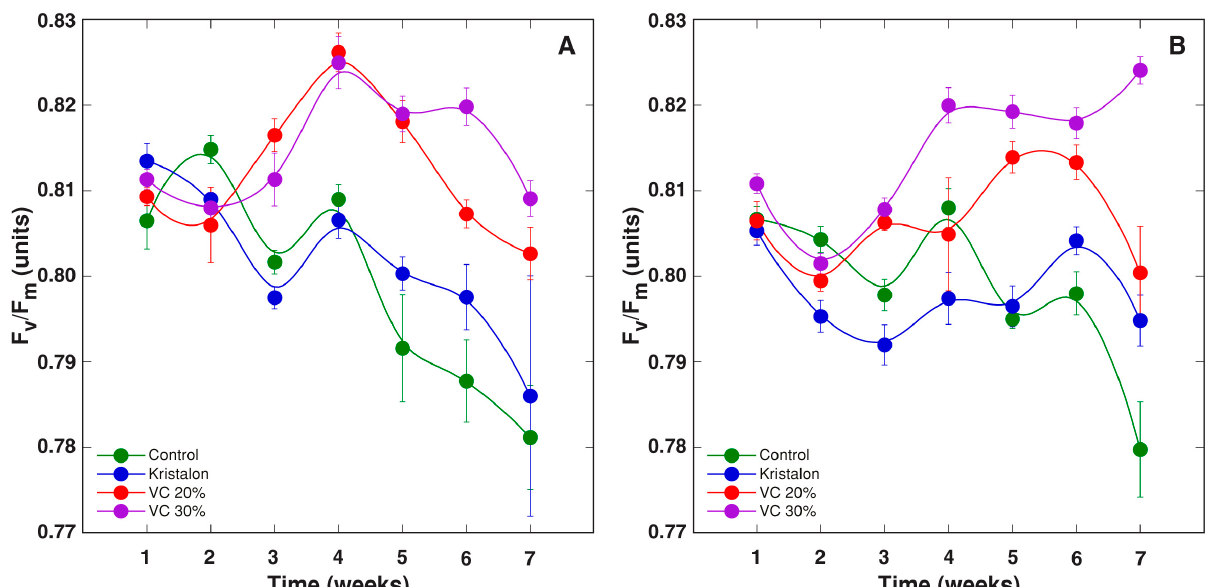
Figure 9. Changes of chlorophyll a fluorescence parameter F v /F m as affected by mineral fertilizer (Kristalon) and amendment with vermicompost (VC) at a 20% and 30% ( v/v ) rate in Dracocephalum moldavica plants grown in peat substrate ( A ) or commercial garden soil ( B ). Results are means ± SE from five replicates for each treatment, three measurements per replicate.